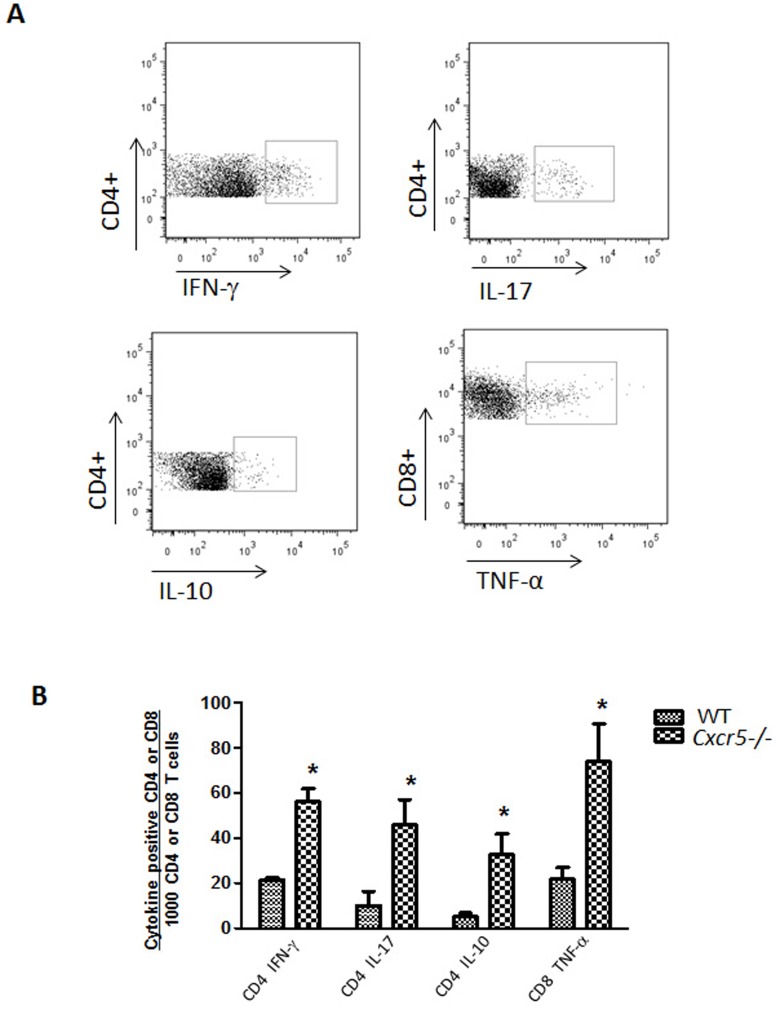
Lymphocytes accumulate in the oviducts of Cxcr5−/− mice following infection.GTs were harvested 49 days after vaginal infection with C. muridarum and used to isolate lymphocytes from the oviducts. (A) Representative dotplots of oviduct lymphocyte subsets stained against surface markers and intracellular cytokines. Cells were gated on CD3+CD4+ or CD3+CD8+ cells. (B) The number of lymphocyte subsets as determined in panel B, were compared between groups. Bars equal the mean ± SD. *p<0.01 (Bonferroni's modified t test). n = 3–4 oviduct pools/group.